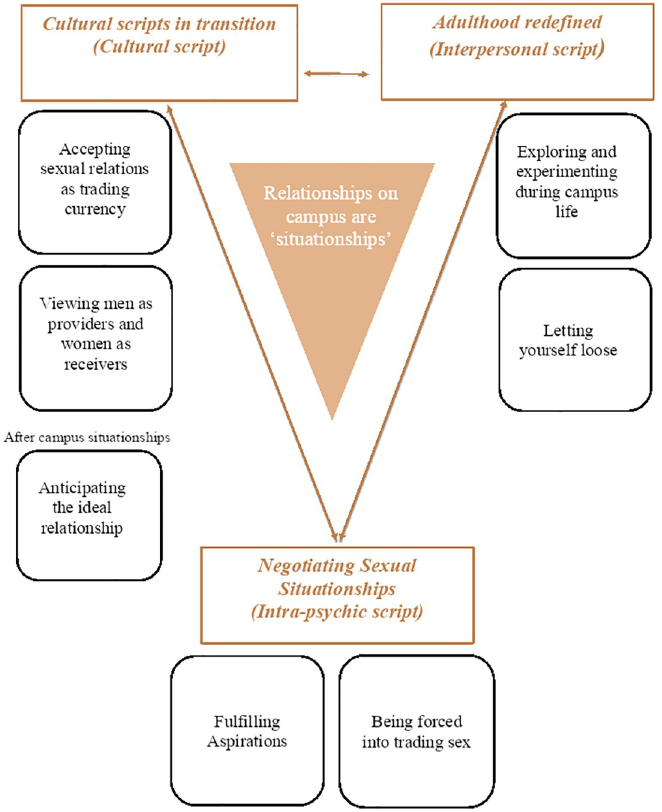
Fig 1. Analytical model for role of sexual relationships in lives of Ugandan undergraduate students as sexual scripts.